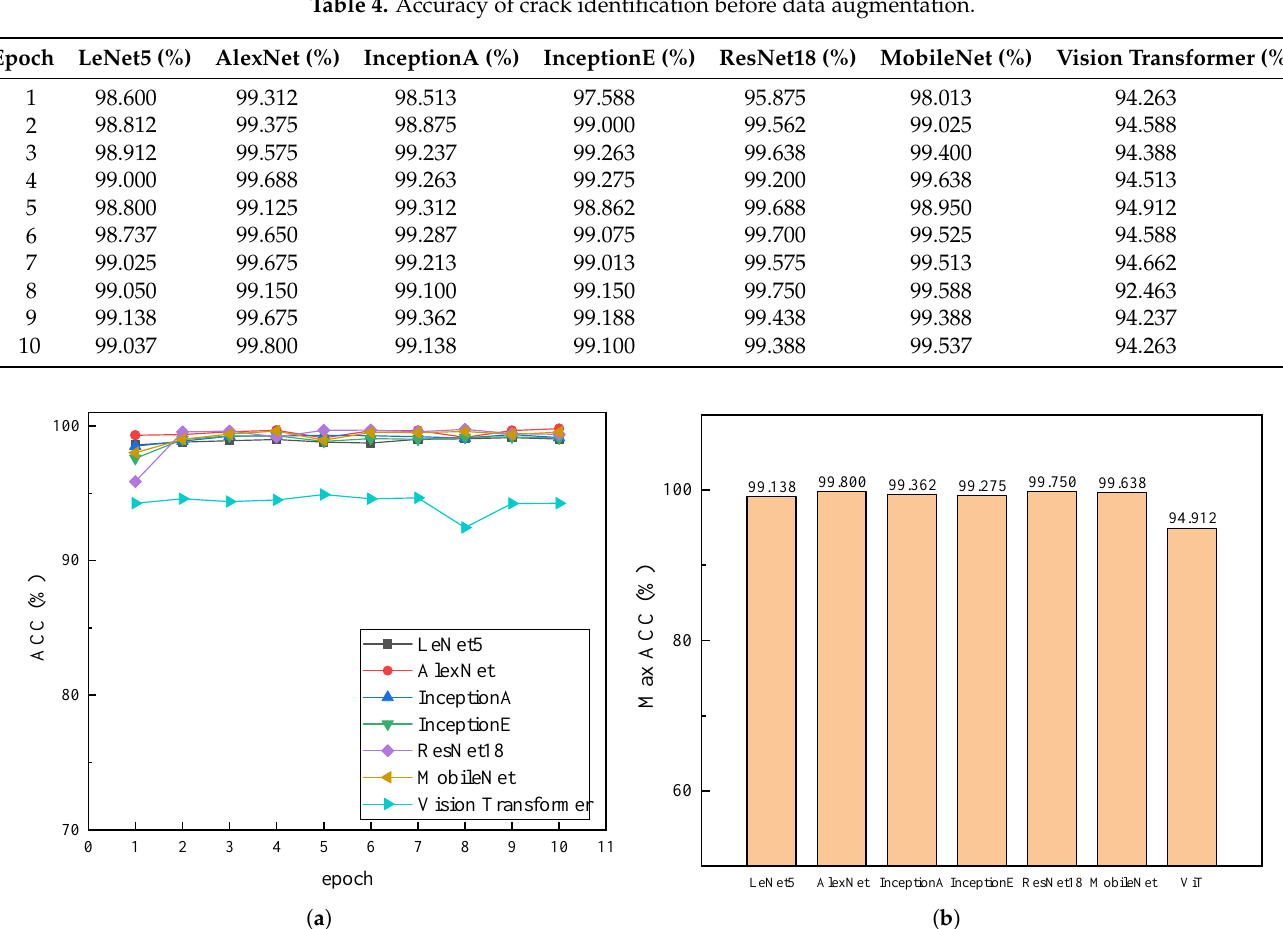
Table 4. Accuracy of crack identification before data augmentation.